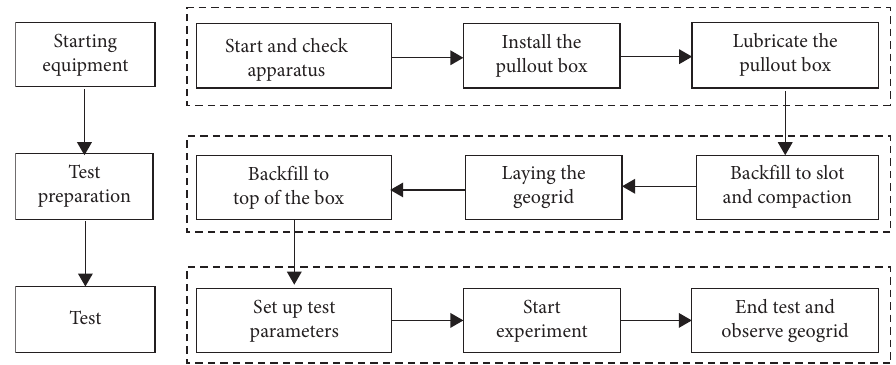
Figure 5: The test procedures in this